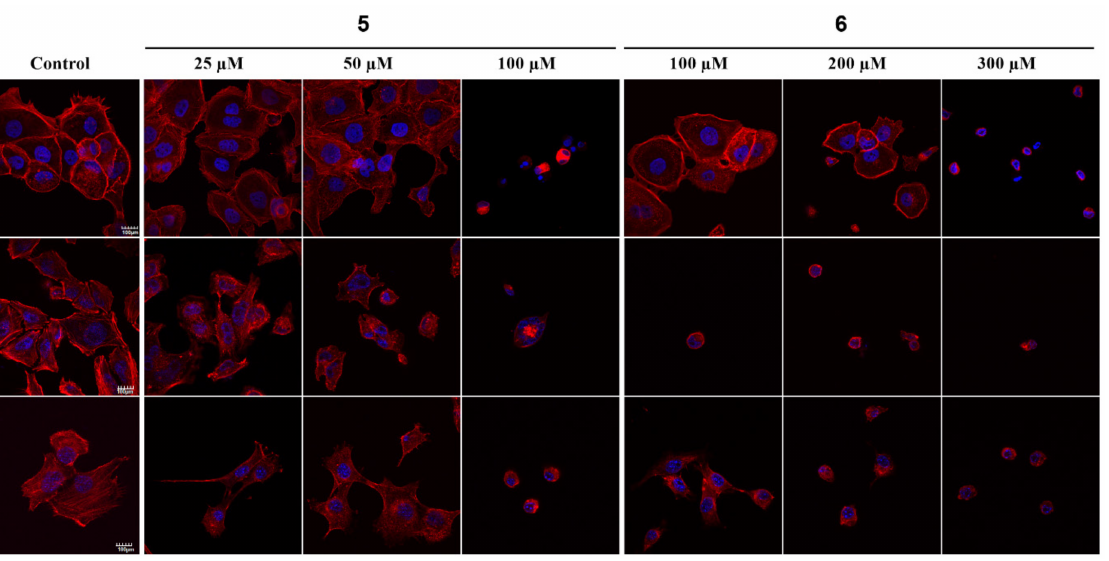
Figure 7. Immunofluorescence studies of C32, A375 and HaCaT cells’ structure (60 × ) 24 h after the treatment with compounds 5 and 6 . DAPI (4 (cid:48) ,6-diamidino-2-phenylindole) was used for nuclei staining (blue) and actin filaments were labeled with phallotoxin